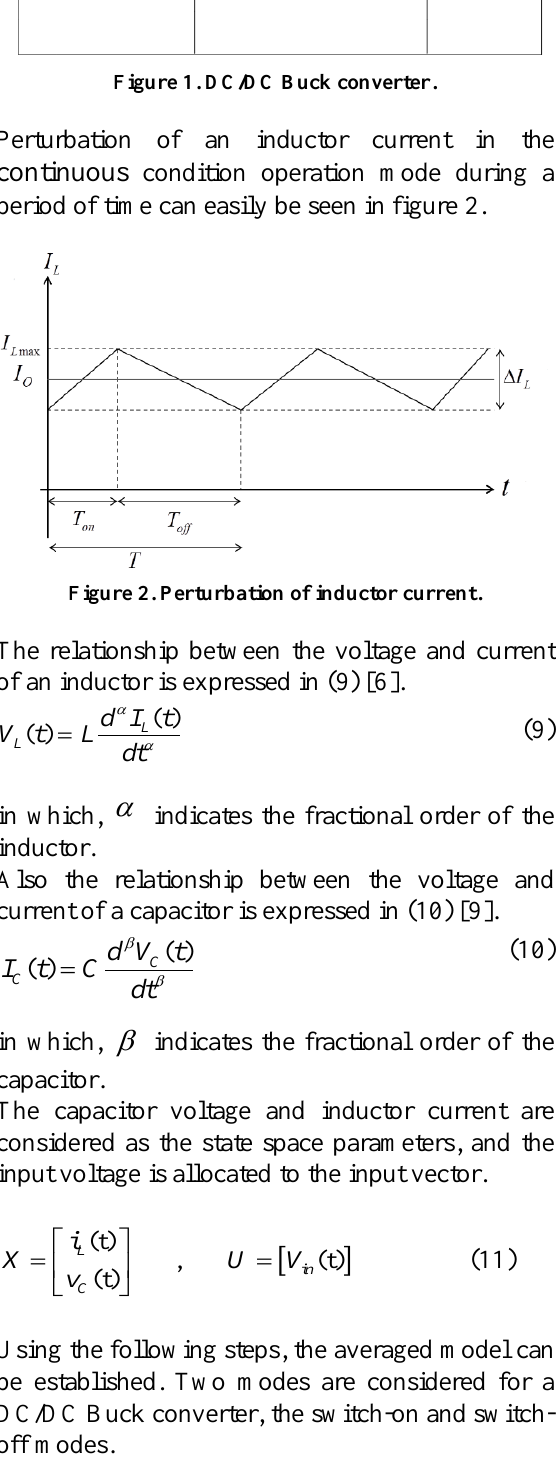
Figure 4. Switch-off mode